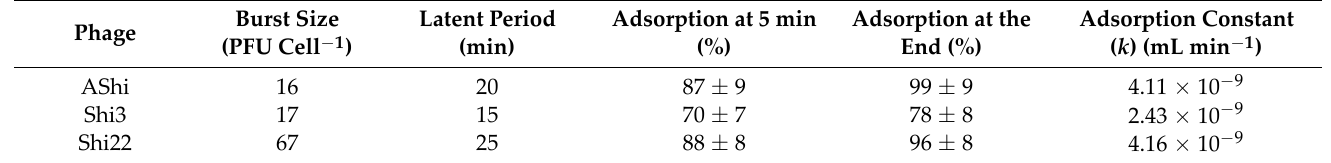
Table 1. Parameters calculated from the one‑step growth curve and adsorption rate